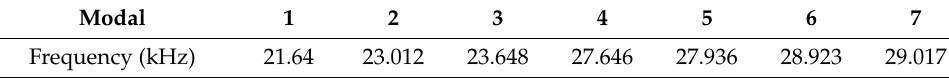
Table 4. The resonant frequency of the traditional microdissection